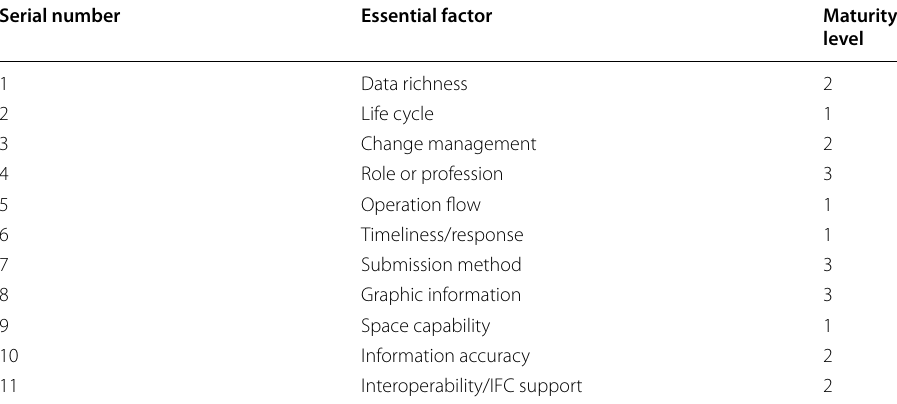
Table 4. Eleven maturity levels of